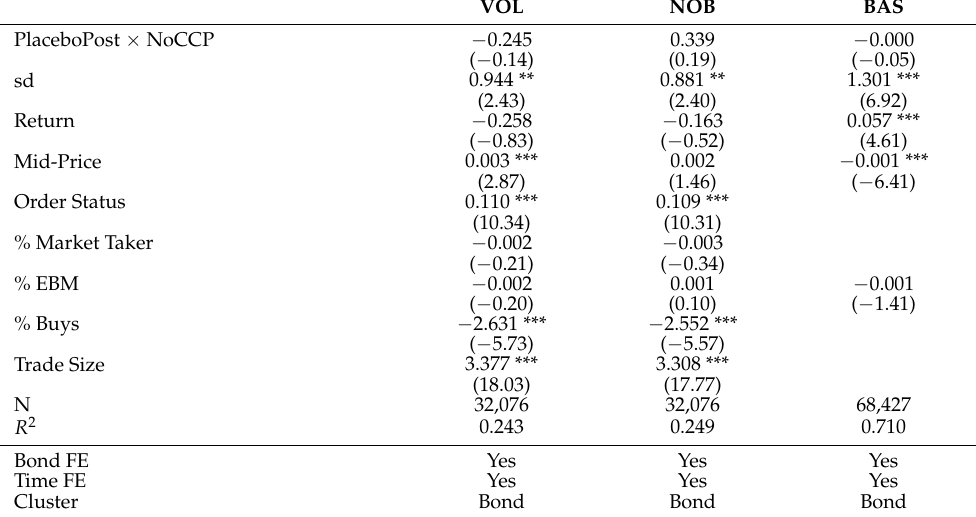
Figure 6. Parallel trends of CCP and non-CCP volume. The figure shows the euro volume between 1 January 2012 and 31 December 2014. The euro volume is a 10-day moving average aggregated over the entire sample (including Spain, Portugal, Greece and France) on a daily basis for the CCP group (blue line) and the non-CCP group (gray line). The euro volume is expressed in millions of euros. Table 9. Placebo